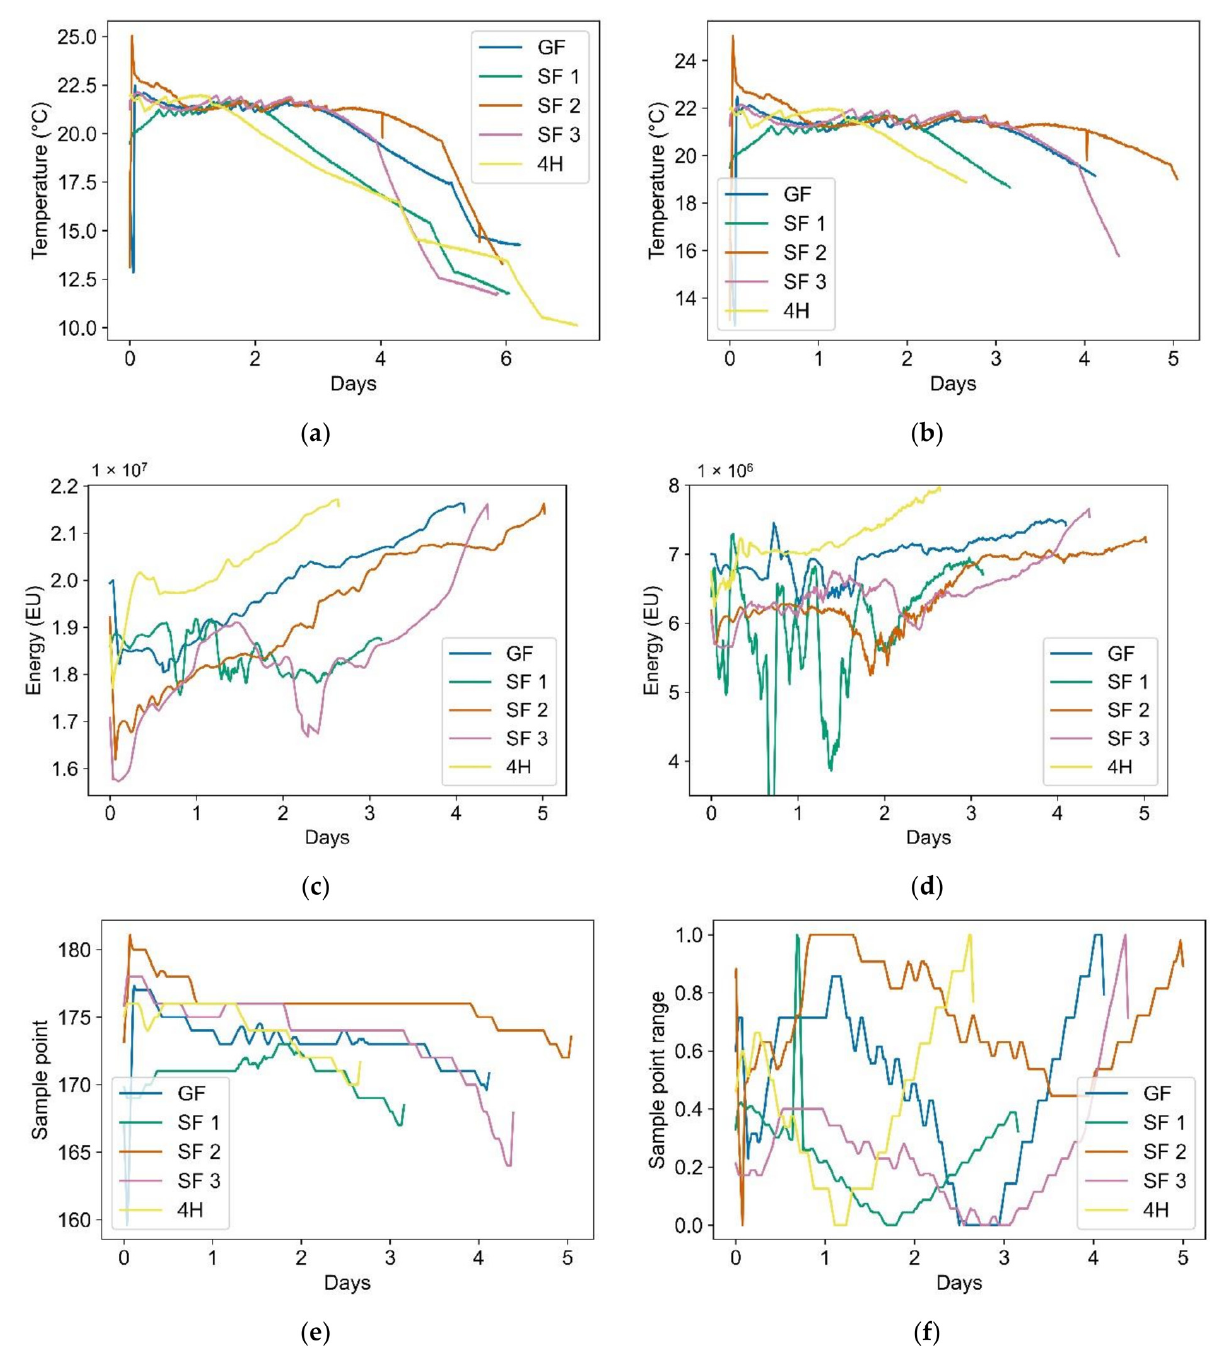
Figure 3. US feature and temperature results for the five industrial fermentation batches. ( a ) The process temperature. ( b ) The process temperature until one day post the end of ethanol production. ( c ) The first reflection energy until one day post the end of ethanol production. ( d ) The third reflection energy until one day post the end of ethanol production. ( e ) The first reflection time of flight measured using a thresholding method until one day post the end of ethanol production. ( f ) The third reflection time of flight measured using a thresholding method until one day post the end of ethanol